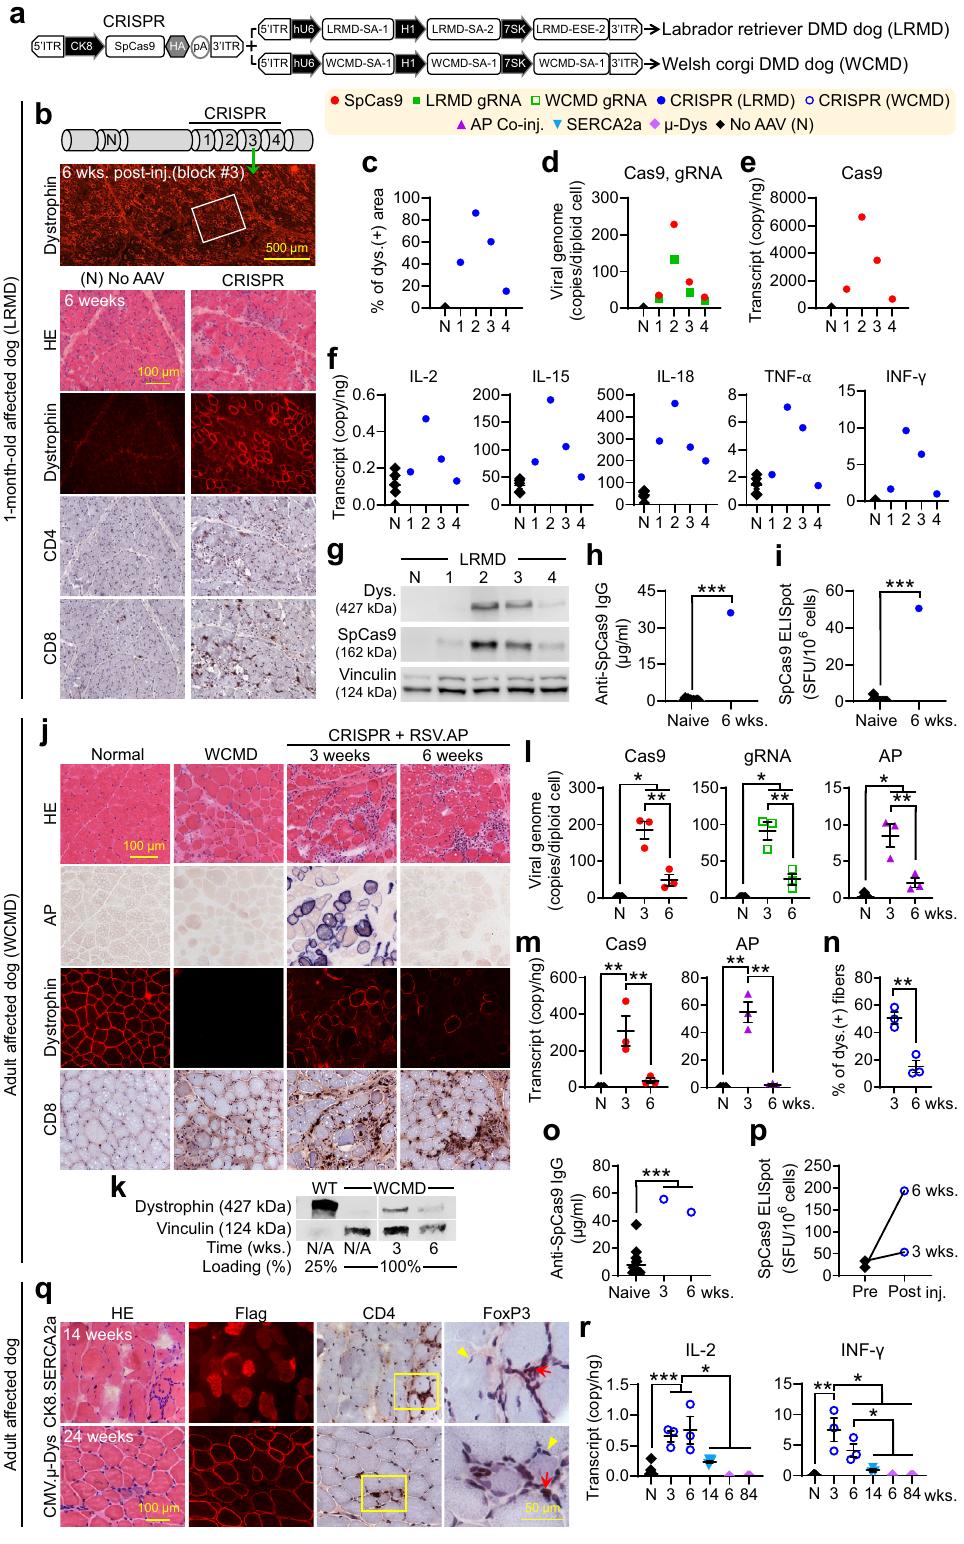
serum cytokine levels were unremarkable (Supplementary Fig. 8b, c). However, a low but signi fi cant T-cell response was detected at 6 weeks post-injection by ELISpot in draining lymph node cells (Fig. 2d, i, o), indicating a local response. Additional studies revealed a similar T-cell response to SpCas9 expressed from a ubiquitous promoter, SaCas9 expressed from the CK8